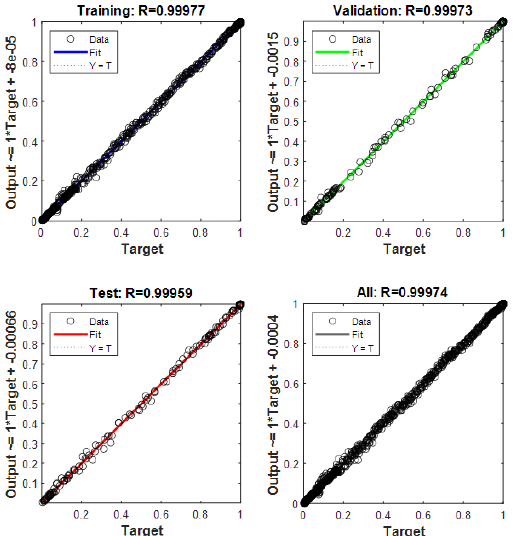
Figure 10. Coefficient of correlation plot for optimal neural network.